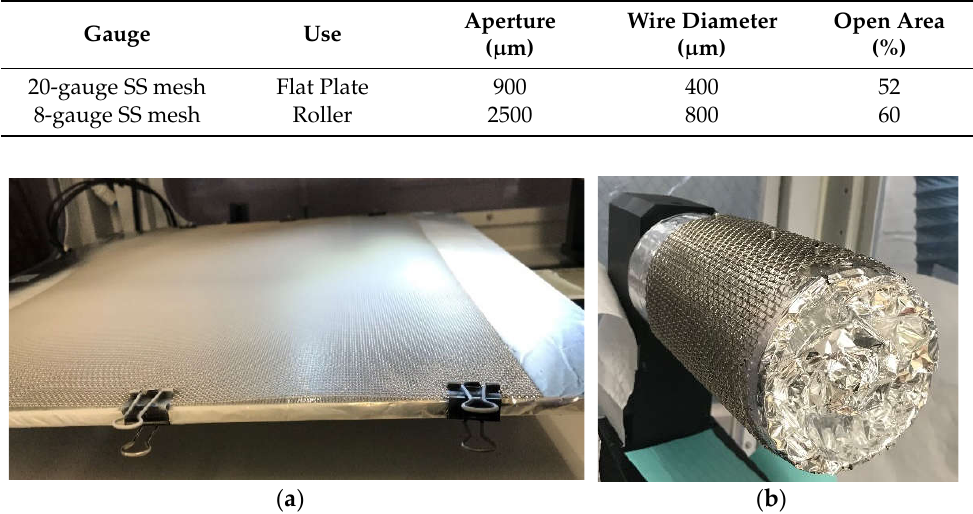
Figure 2. Stainless steel woven wire mesh. ( a ) Flat plate collector. ( b ) Roller collector. Table 1. Stainless steel wire mesh dimensions.